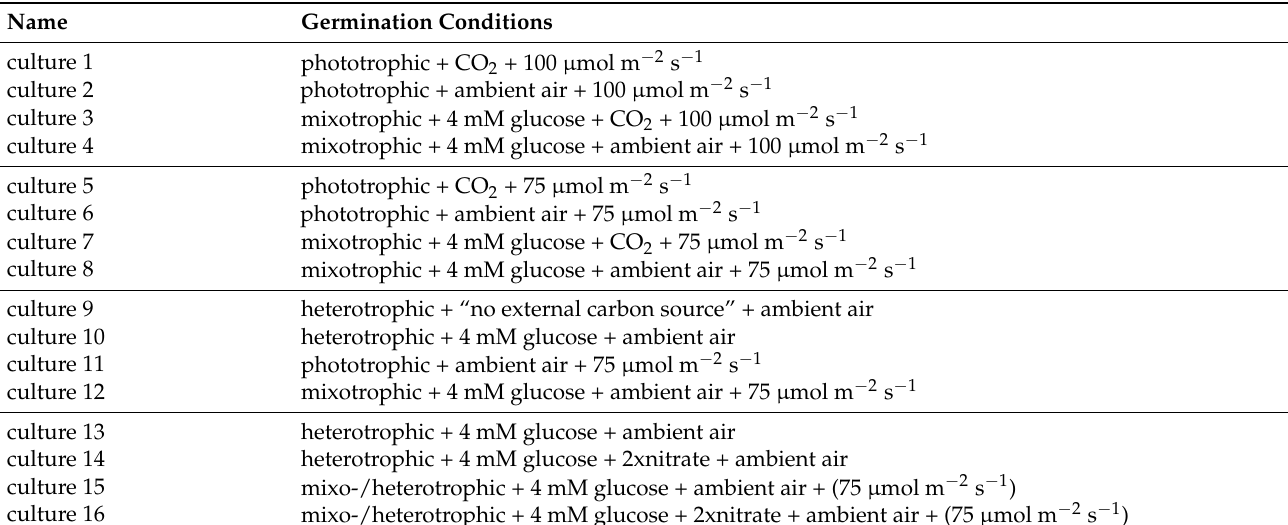
Table 1. Applied germination conditions, each culture represents one biological